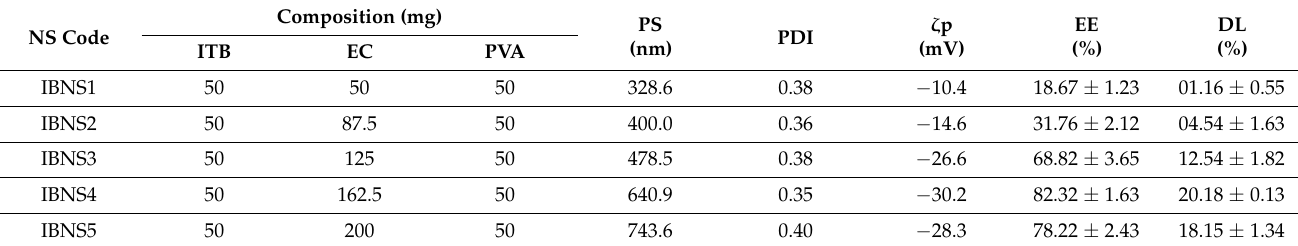
Table 1. Composition and physicochemical nanosponge